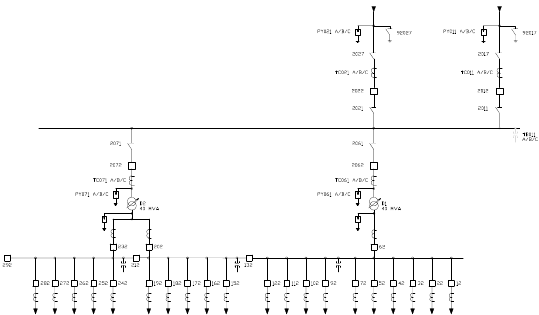
Figure 1. Modelled 115 kV main one-line diagram.